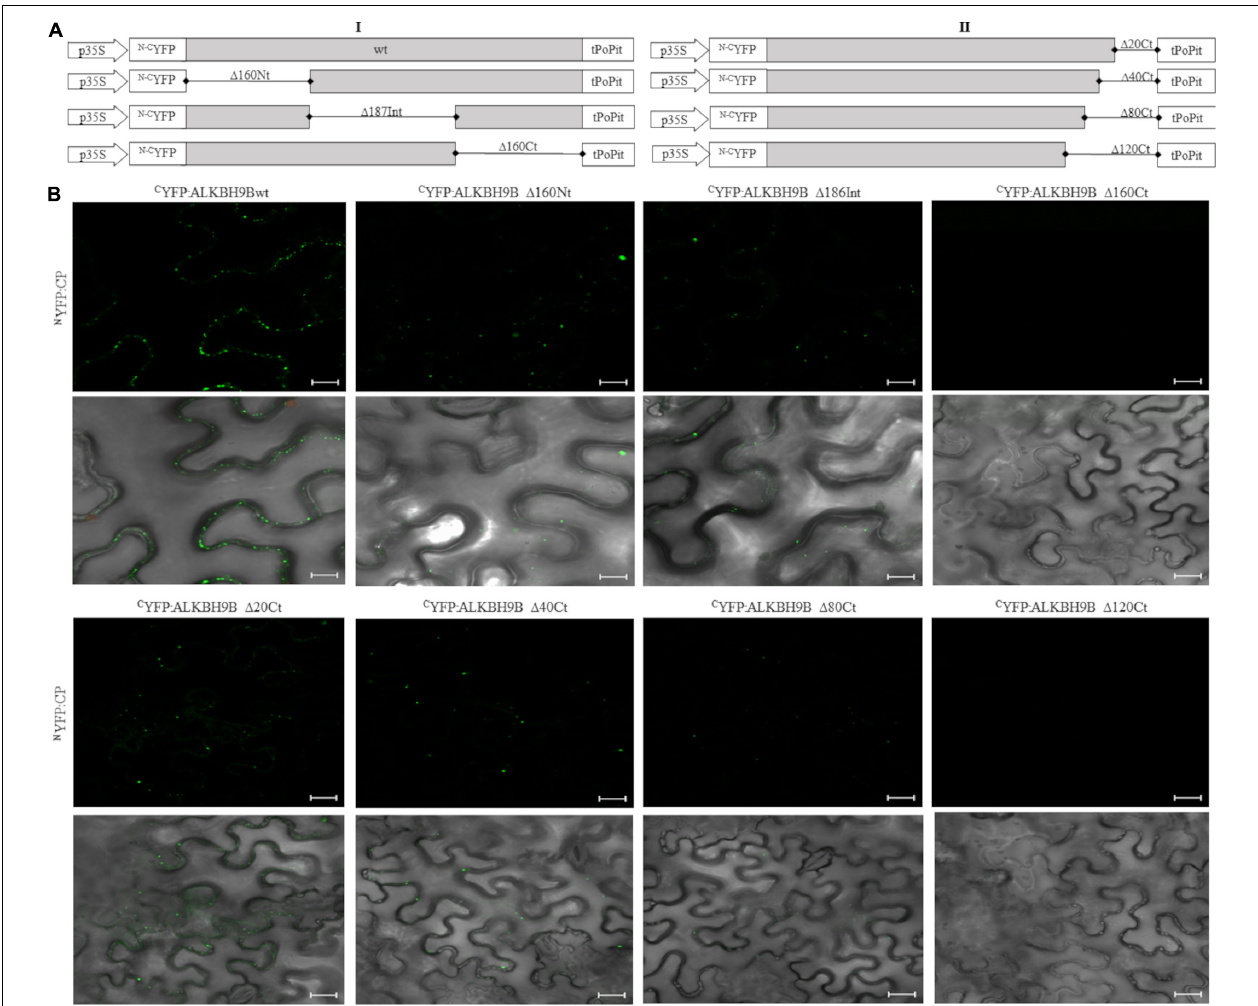
FIGURE 5 | In vivo BiCF visualization of the interaction between N − C YFP: at ALKBH9B fusion proteins and N − C YFP:CP of AMV in N. benthamiana . (A) Schematic representation of the N − C YFP: at ALKBH9B fusion proteins. (B) BiFC images of epidermal cells co-infiltrated with C YFP: at ALKBH9B proteins combined with the N YFP:CP, previously described in Aparicio et al. (2006). Scale bar = 20 µ